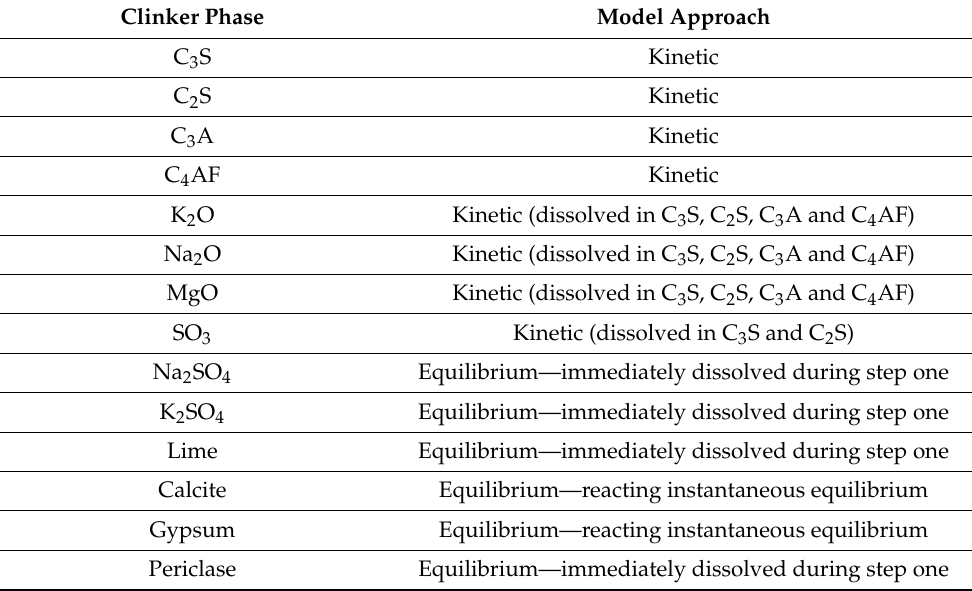
Table 5. Modelling approach for the hydration behaviour of the clinker